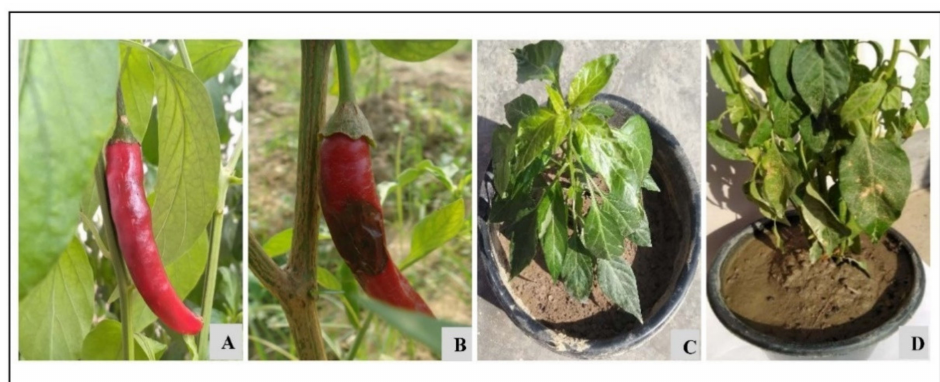
Figure 2. Pathogenicity test on chilli fruit and leaf. ( A ) Water-treated control showing no symptoms on the fruit of Capsicum annuum (cv. Surajmukhi). ( B ) Fruit challenged with the conidial suspension of C. truncatum showing anthracnose symptoms after 7 days of inoculation. ( C ) Healthy plant served as a control. ( D ) Leaves sprayed with the conidial suspension showing symptoms after 7 days of inoculation.